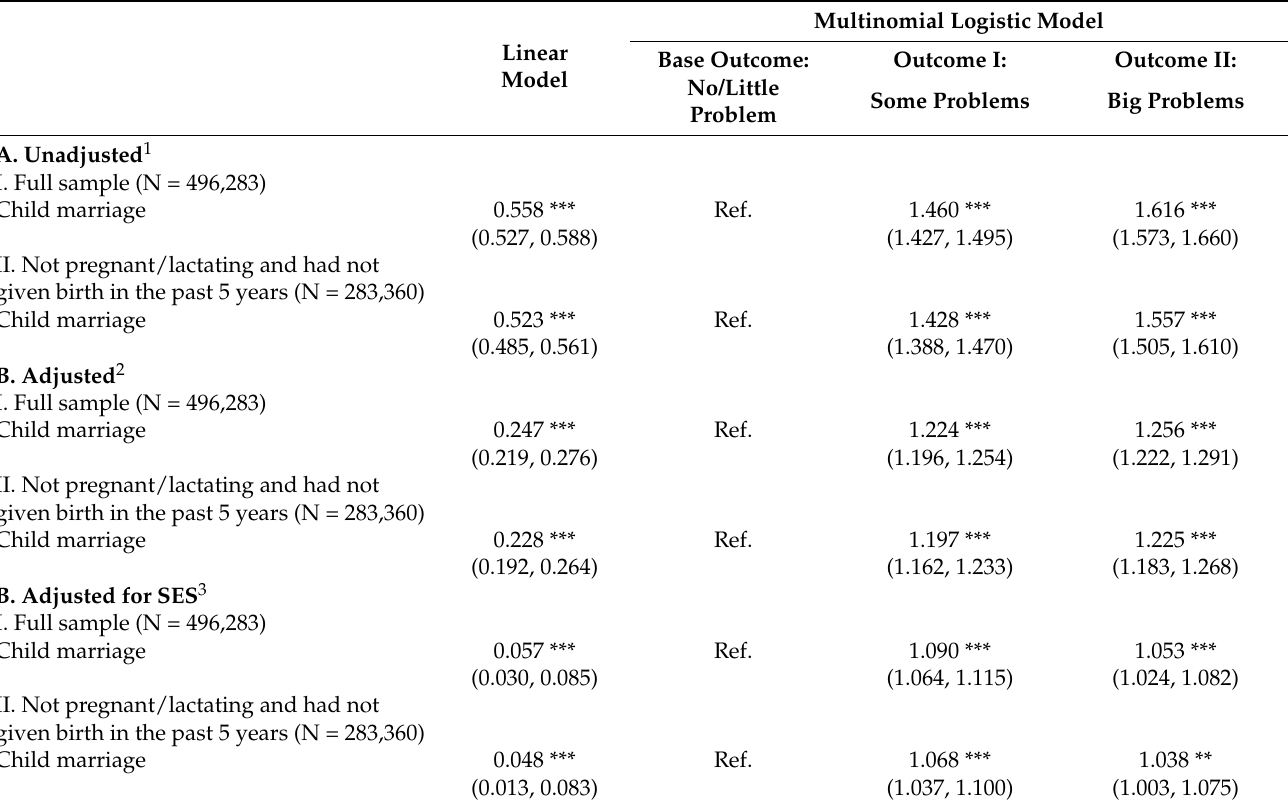
Table 5. Estimates of linear regression and relative risk ratios for facing problems accessing healthcare categorized by